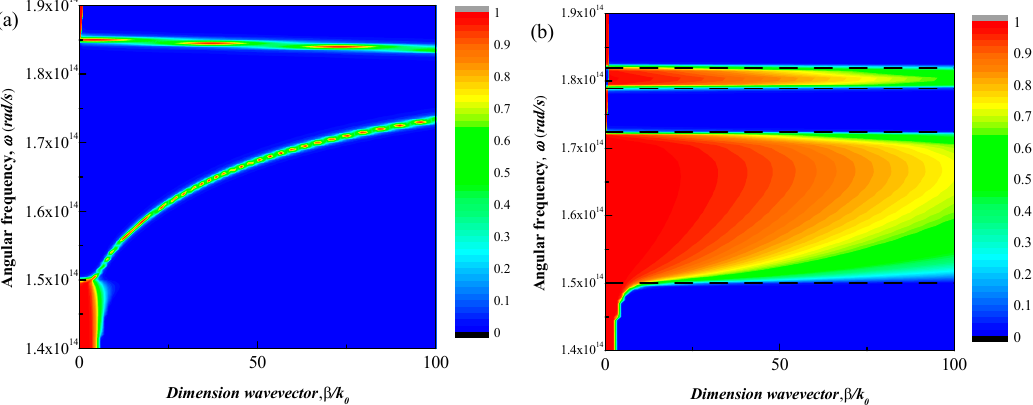
Figure 6. Contour of the transmission coefficient for ( a ) SiC plates and ( b ) SiC Nanowires at d = 10 nm.